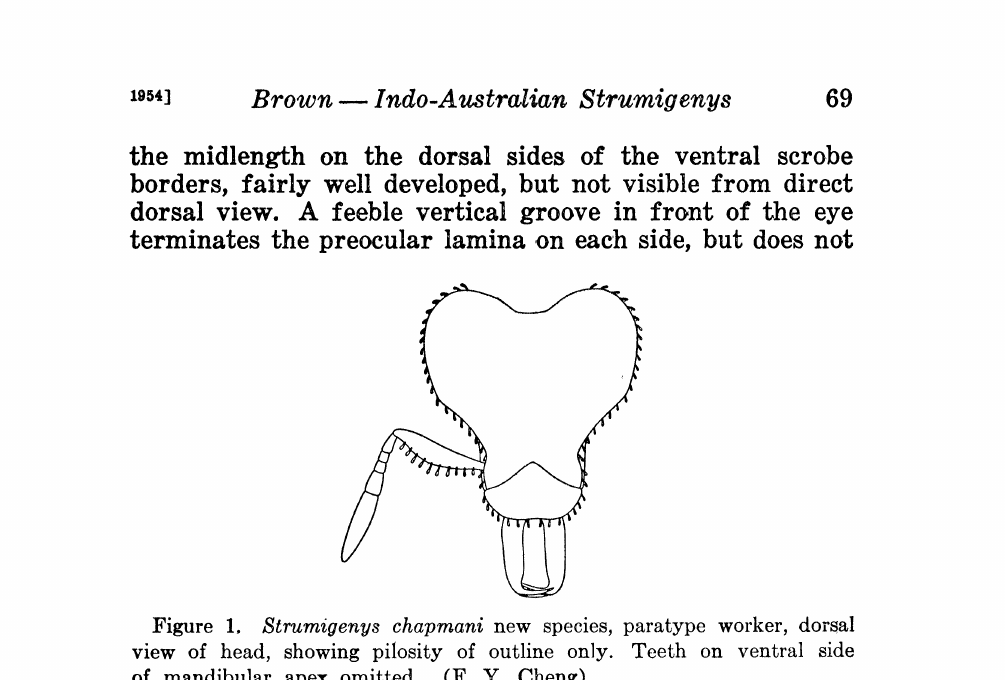
Figure 1. Strumigenys chapmani new species, paratype worker, dorsal view of head, showing piiosity of outline only. Teeth on ventral side of mandibular apex omitted. (F. Y.